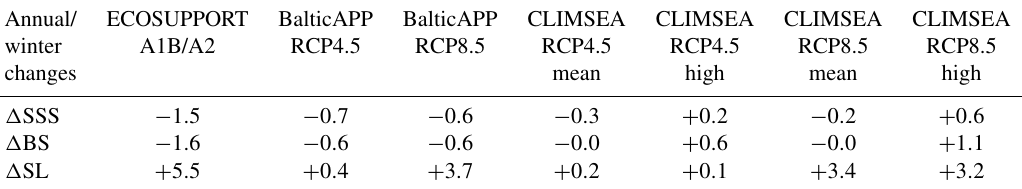
Table 8. Ensemble mean changes in annual mean sea surface salinity (SSS; in gkg − 1 ), annual mean bottom salinity (BS; in gkg − 1 ) and winter mean sea level (SL) relative to the global mean SL (in cm) in ECOSUPPORT, BalticAPP RCP4.5, BalticAPP RCP8.5, CLIMSEA RCP4.5 and CLIMSEA RCP8.5 scenario simulations averaged for the Baltic Sea including the Kattegat. For CLIMSEA, both the ensemble mean and the high SL scenarios are listed. In ECOSUPPORT and BalticAPP/CLIMSEA, the changes between 1978–2007 and 2069–2098 and between 1976–2005 and 2069–2098 were calculated, respectively. (Data sources: Meier et al., 2011b, 2021; Saraiva et al., 2019a.)